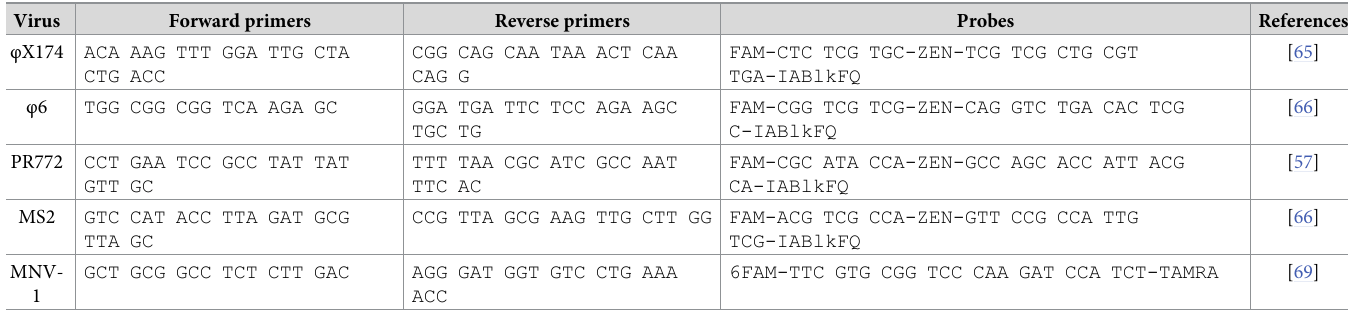
Table 2. Primers and